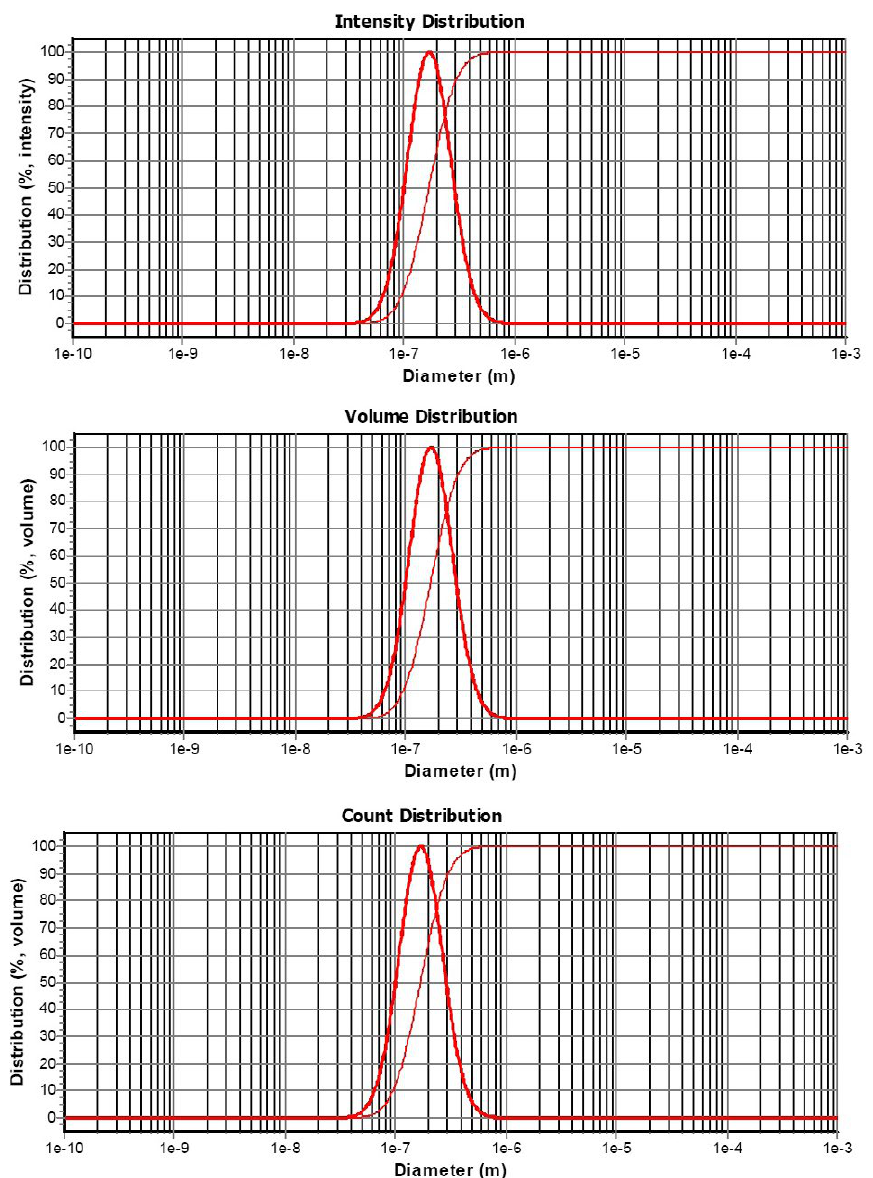
Fig. 3. DLS of ZnO NPs at room